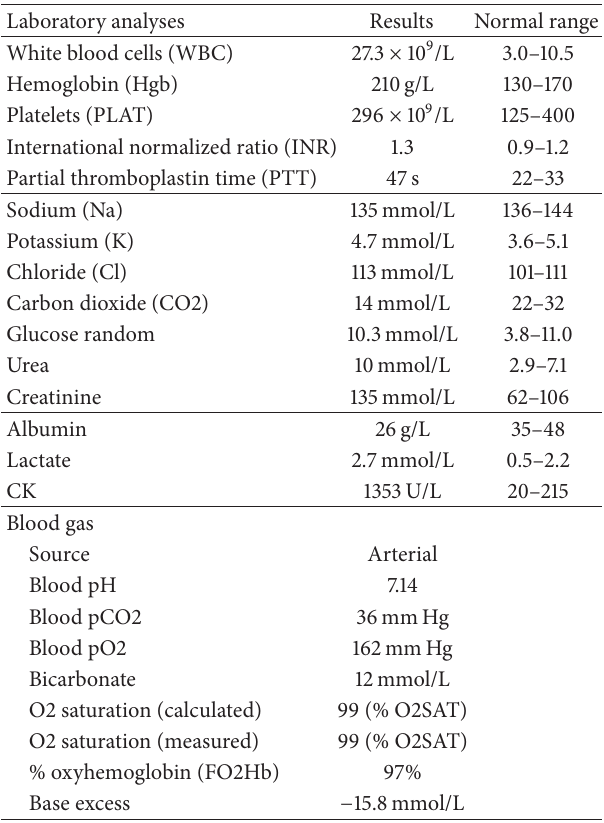
Table 1: Laboratory assessments, patient results, and the expected range of analyses.